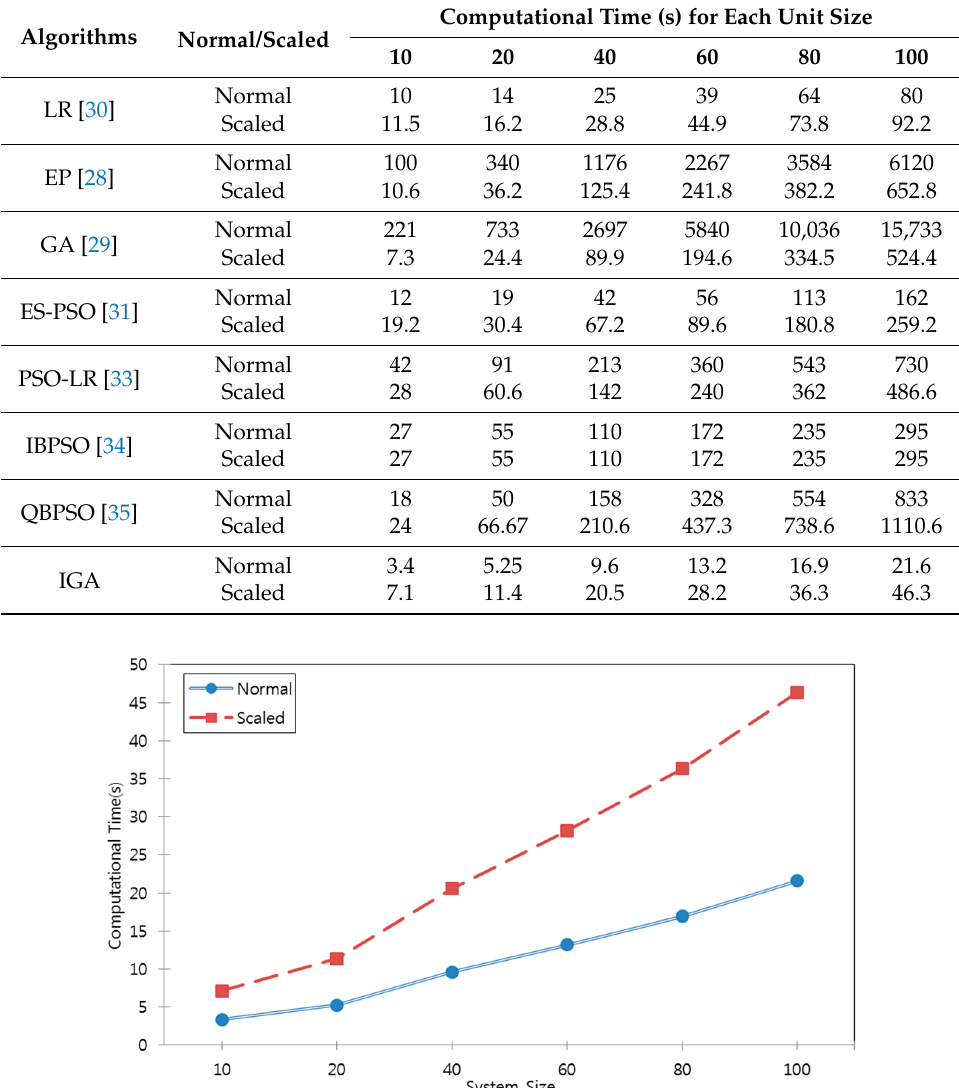
Table 2. Comparison of computational time.